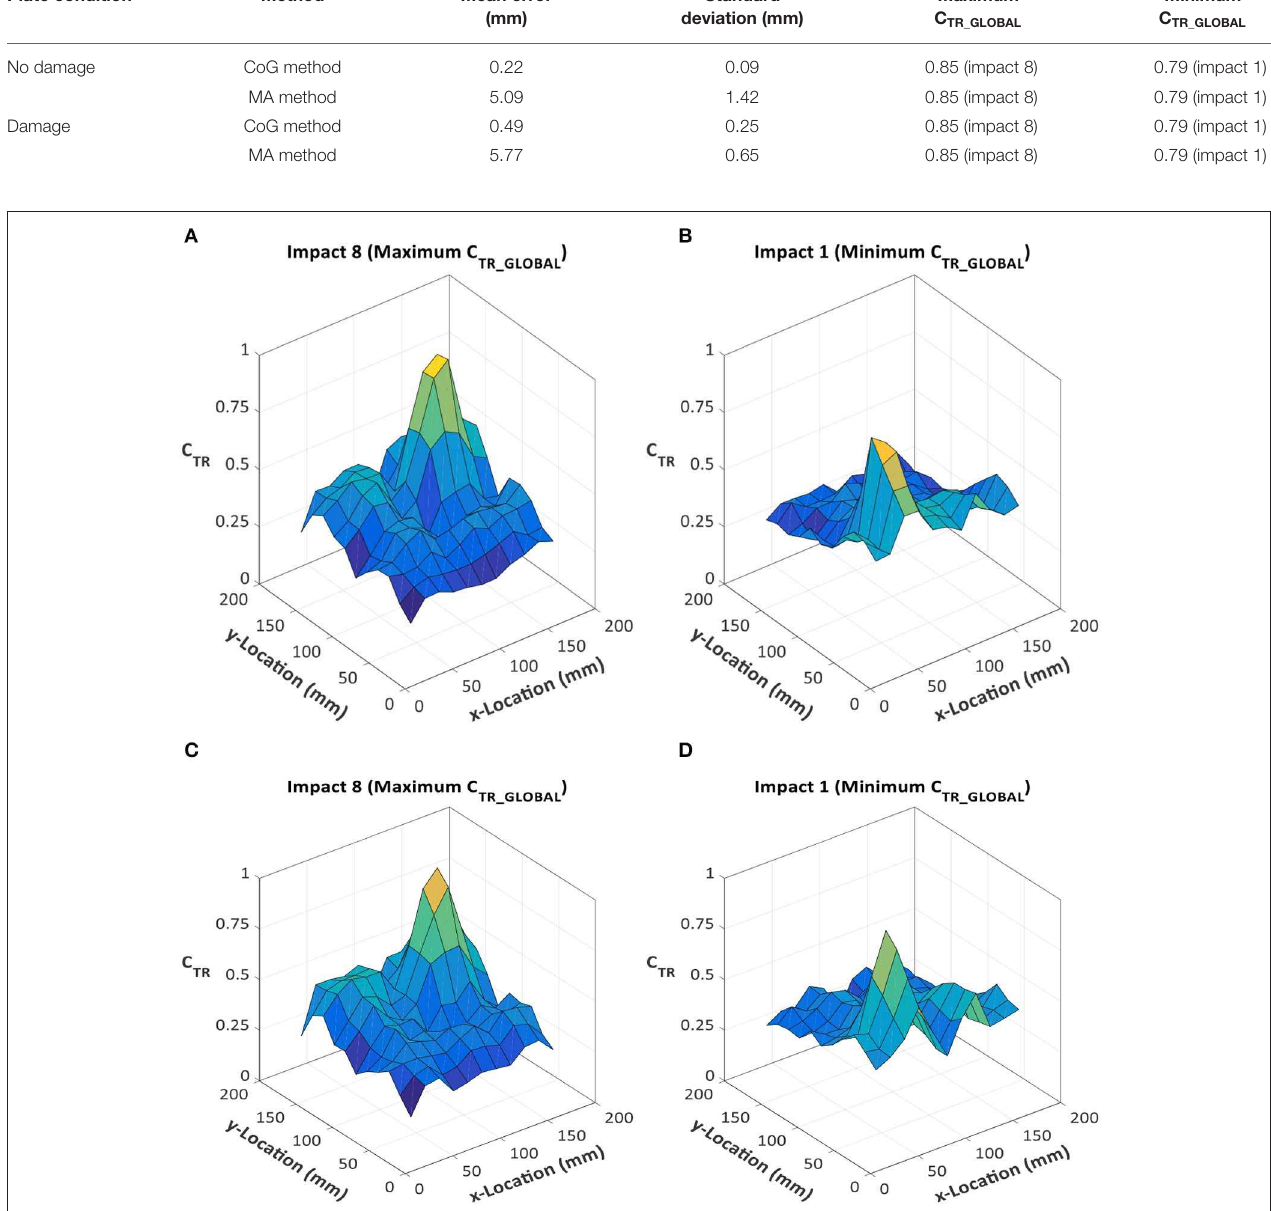
FIGURE 11 | C TR distributions for impacts associated to the maximum and minimum C TR_GLOBAL values, and no grid refinement, both with and without damage present. (A) No damage maximum C TR_GLOBAL ; (B) No damage minimum C TR_GLOBAL ; (C) same impact location as (A) with damage; (D) same impact location as (B) with